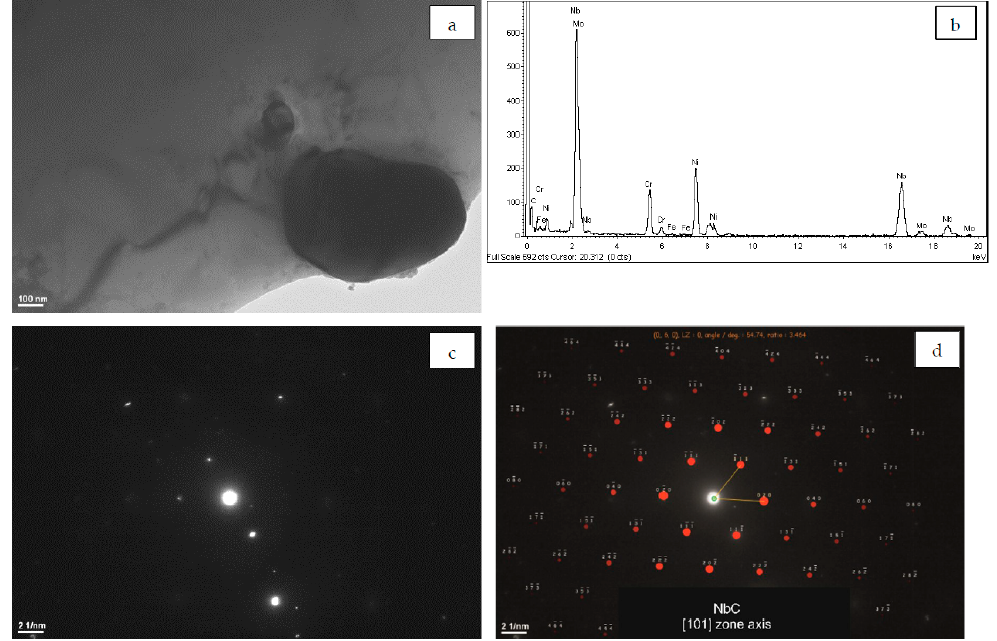
Figure 3. ( a ) TEM image of the MC precipitate; ( b ) the corresponding energy-dispersive X-ray spectroscopy (EDS) spectrum; ( c ) selected area electron diffraction (SAED) pattern; and ( d ) its solution for NbC [101] zone axis.